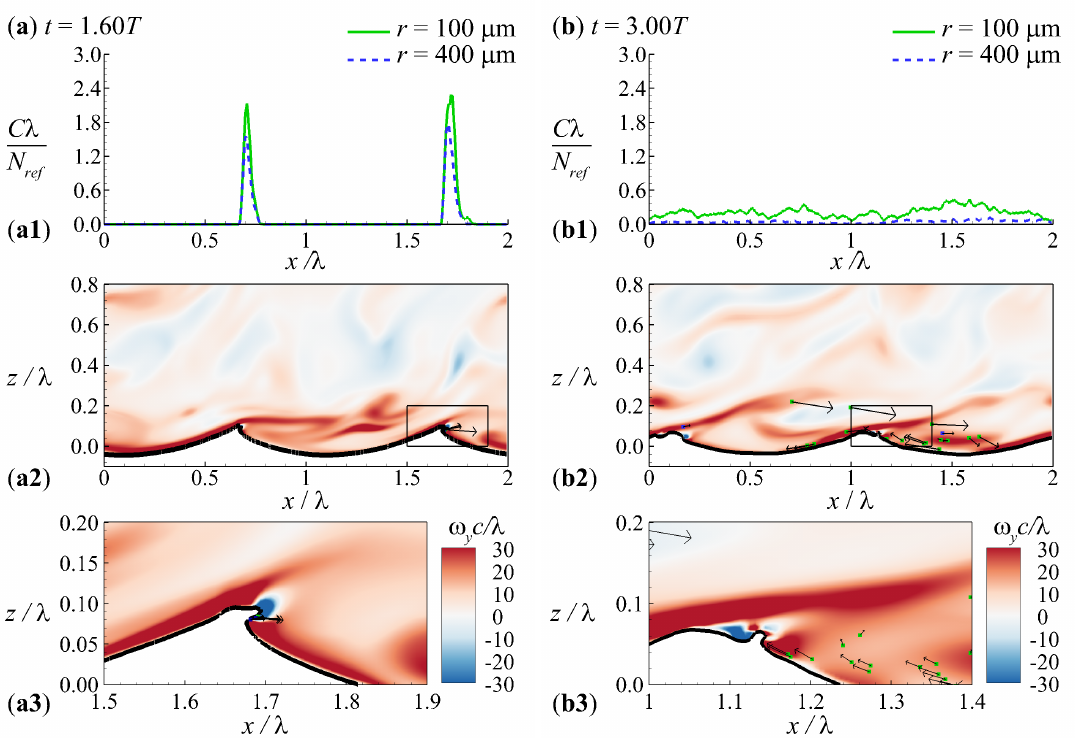
Figure 5. See Figure 3 for the caption. Here, the results of Case A38 at ( a ) t = 1.60 T and ( b ) t = 3.00 T are shown instead.